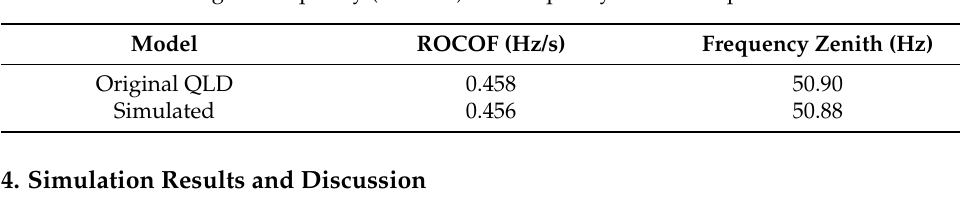
Figure 5. ( a ) Active power response of SGs and ( b ) frequency response of QLD power system. Table 2. Rate-of-change of frequency (ROCOF) and frequency zenith